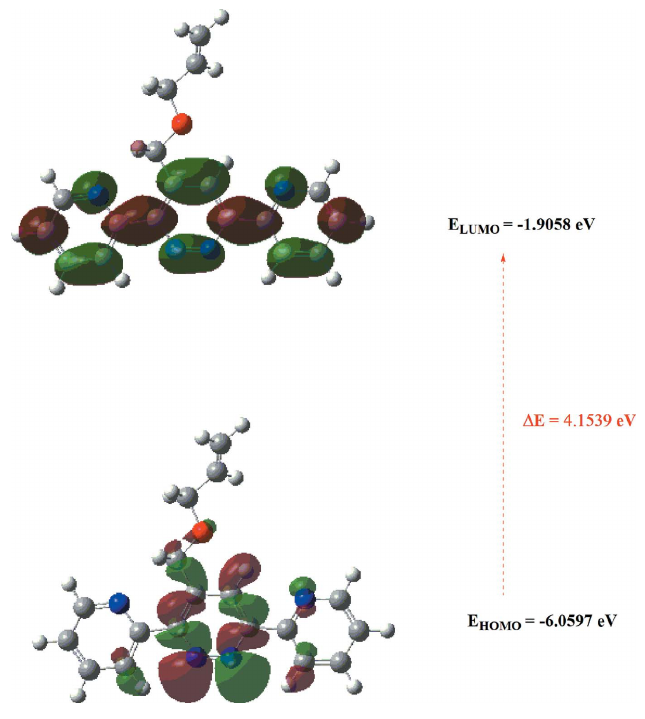
Figure 9 The energy band gap of the title